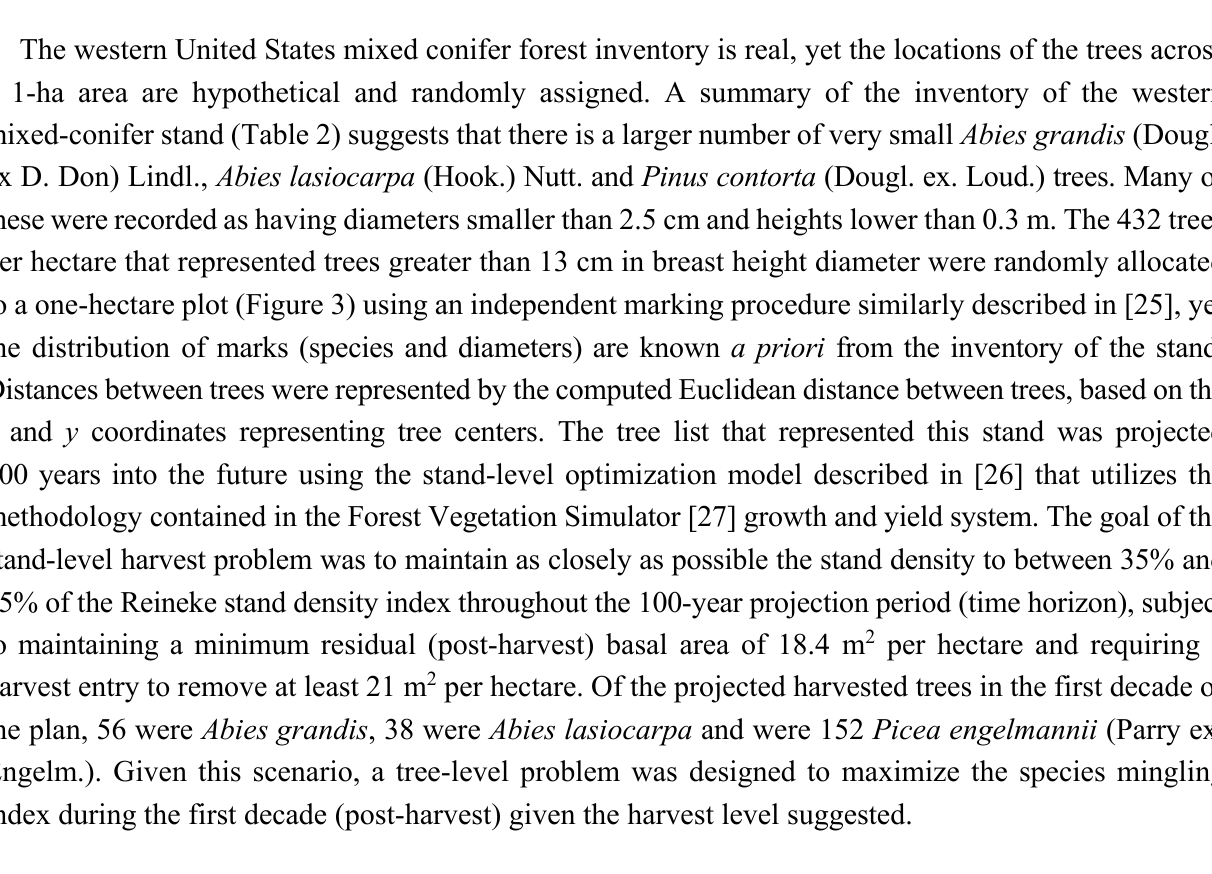
Table 2. Characteristics of the case study uneven-aged mixed-conifer stand in eastern Oregon (western United